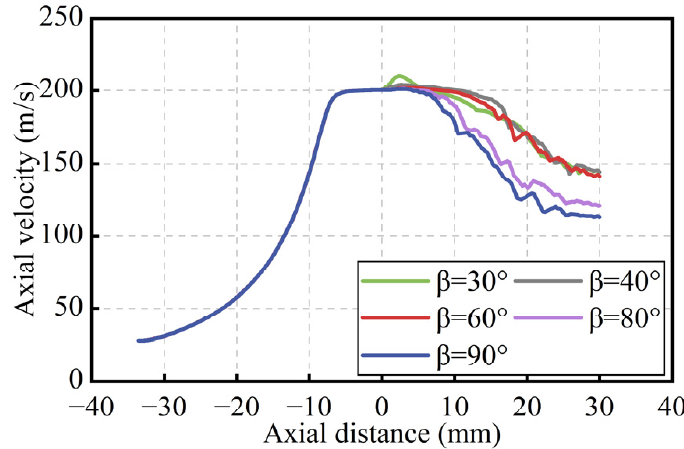
Figure 20. Effect of β on the fluid velocity.